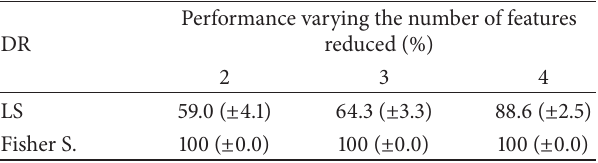
Table 3: Performance of the novelty detection increasing the num- ber of initial features from 10 to 15 and varying the number of the reduced set of